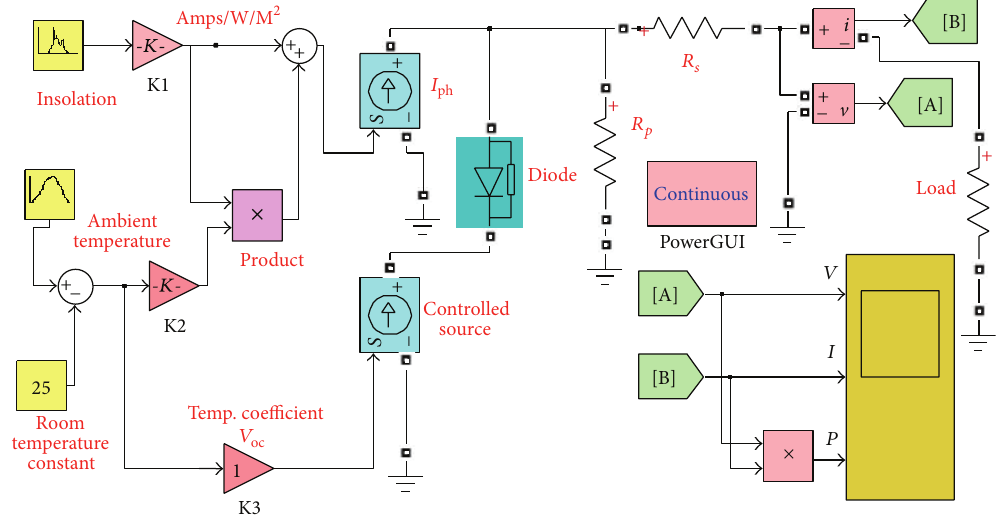
Figure 3: Simulink model of PV cell (with varying insolation and temperature).